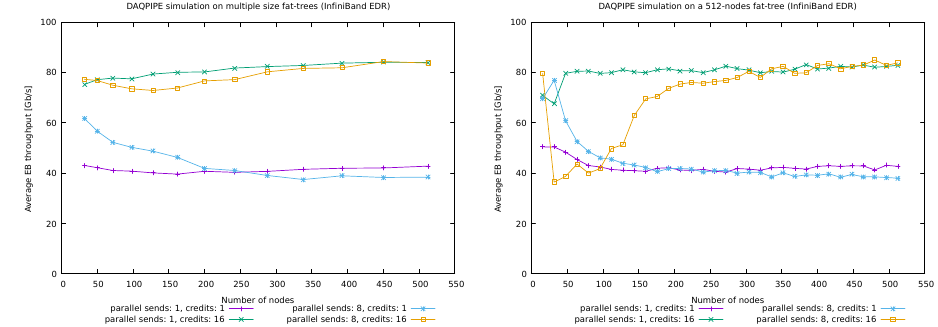
Figure 5. Average EB throughput of simulated DAQPIPE vs the number of nodes. All the net- work topologies tested are full fat-trees; the di ff er- ent node count is achieved by changing the switch radix.